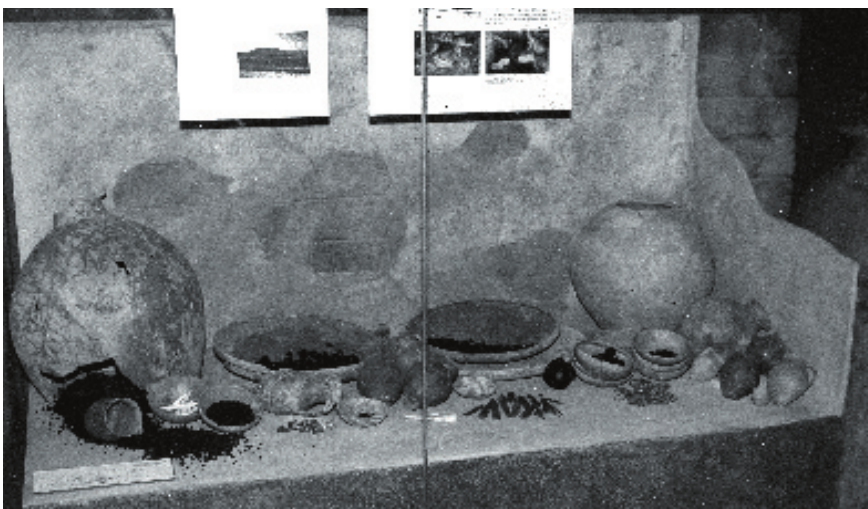
Figure 3 : Reconstruction of the scullery in the British Museum. The original placing of the individual artefacts has been retained in the display. (Please note that the objects are in the Museum as a result of an authorised division between the Department of Antiquities of Jordan and the expedition.) Courtesy of Jonathan Tubb, British